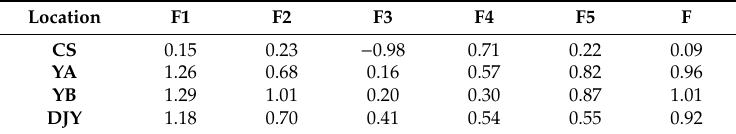
Table 4. Comprehensive evaluation score of environmental factor (F), comprehensive evaluation score of environmental factor. According to the factors within the contribution of di ff erent evaluation index for each environment factor, calculate the final score of di ff erent factor = the sum of (environment evaluation index by correspondence factor load) / (the sum of corresponding factor load).